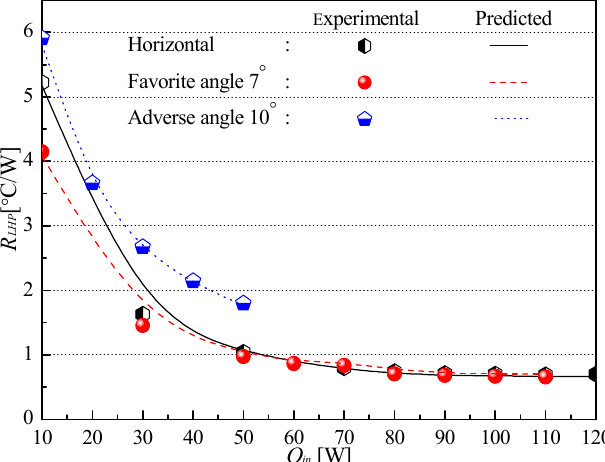
Figure 13. Comparison between experimental and analytical results concerning vapor temperature in the three orientations.